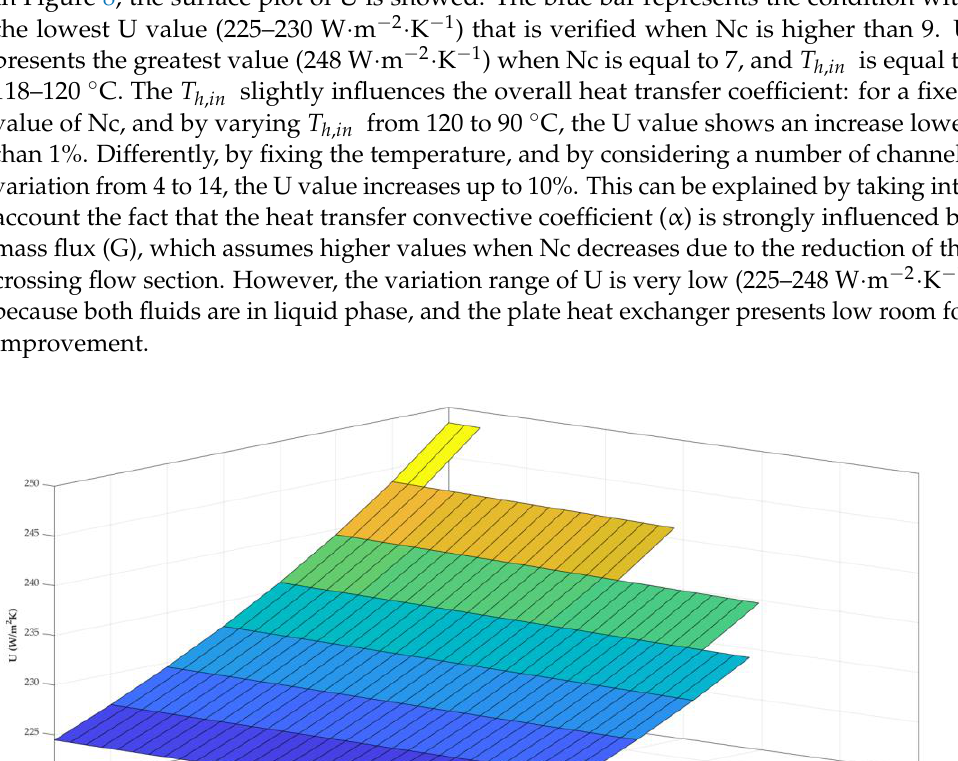
Figure 7. Temperature trend of cold water for Nc = 12 and 𝑇 ℎ,𝑖𝑛 = 115 °C.